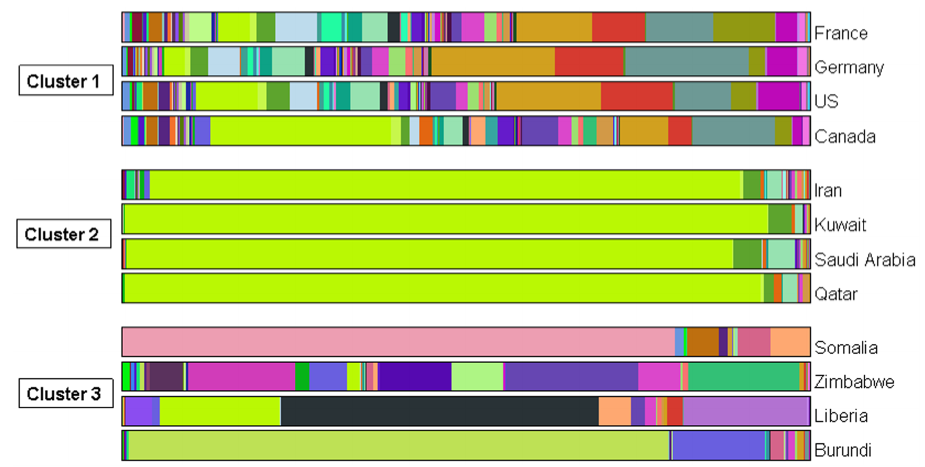
Figure 1. Trade share plot. In this figure we report for each country, classified in the relative cluster, a coloured bar representing the share of export for each of the 97 HS2 product categories over the total amount of export. Regarding Cluster 1 , the high number of colours into the bar makes it clear that these countries use to trade in several product categories. Furthermore, an explicit dependence pattern arise from the proportion of the colours into the bars. In particular, the following product categories contributes to this strong relationship: 84 , 87 , 88 , 85 , 30 , 90 . Regarding Cluster 2 , the dependence relationship mainly arises from these three categories: 27 , 29 , 39 . However, it is important to remark that our clustering approach takes in consideration also the fact that these countries trade in a very small number of products, as can be seen from the few colours in the respective bars. The same reasoning apply for Cluster 3 where, although the countries are specialized in a unique product such as category 9 for Burundi or category 1 for Somalia, the common pattern that makes them similar is the fact that they do not trade in most of the 97 HS2